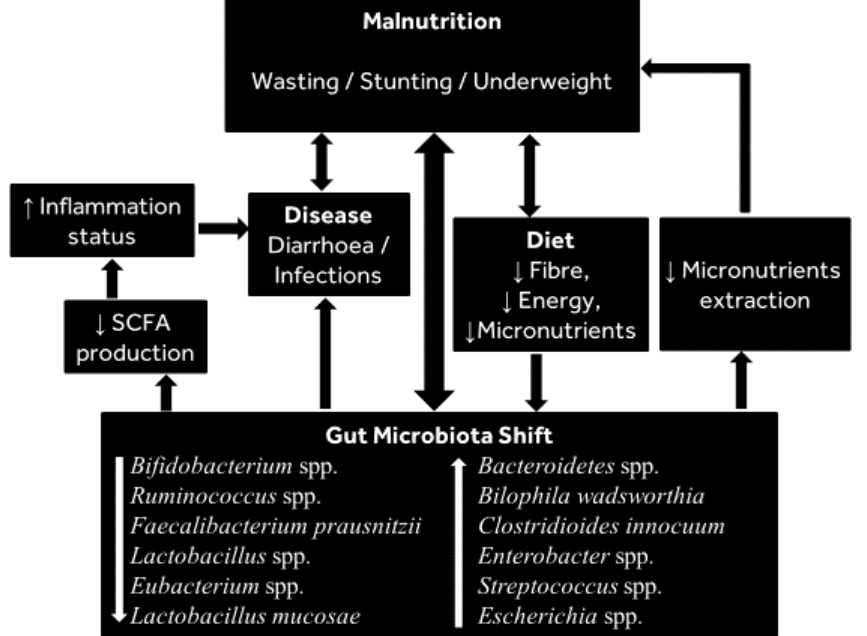
Figure 2. Summary of changes in the gut microbiota associated with childhood malnutrition and key factors linked with such changes. The gut microbiota changes summarise those presented in Table 1, and show reductions in potentially beneficial species and increases in potentially harmful species. Arrows indicate factors that increase or decrease during childhood malnutrition.